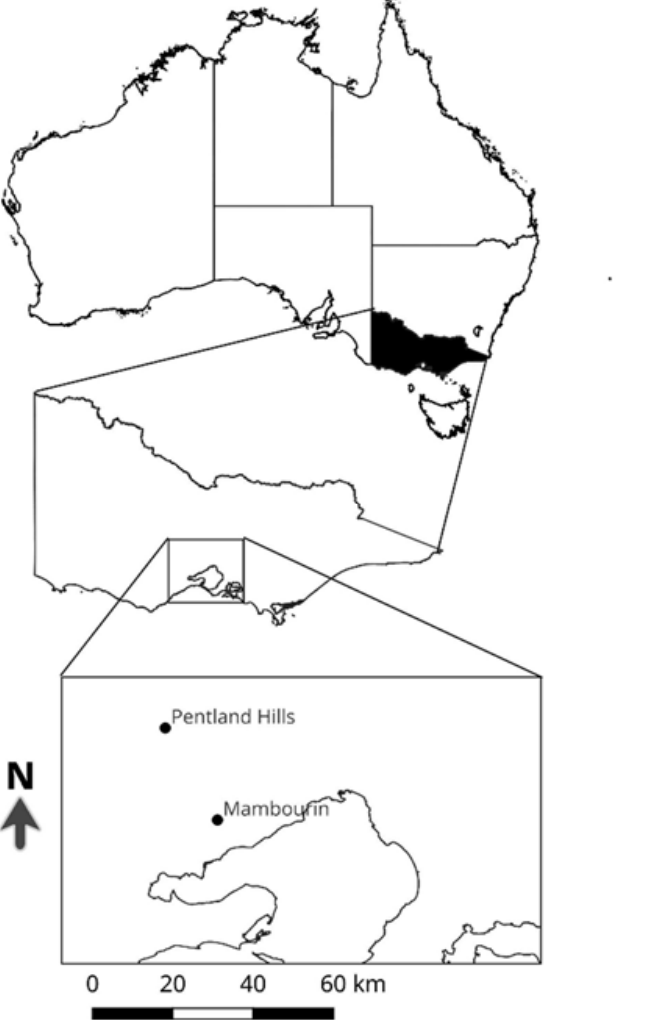
Figure 1. The location of the two sites used to investigate the seedbank persistence of N. trichotoma . The two sites are located within the Greater Western Plains grasslands, located to the west of Melbourne, Victoria.